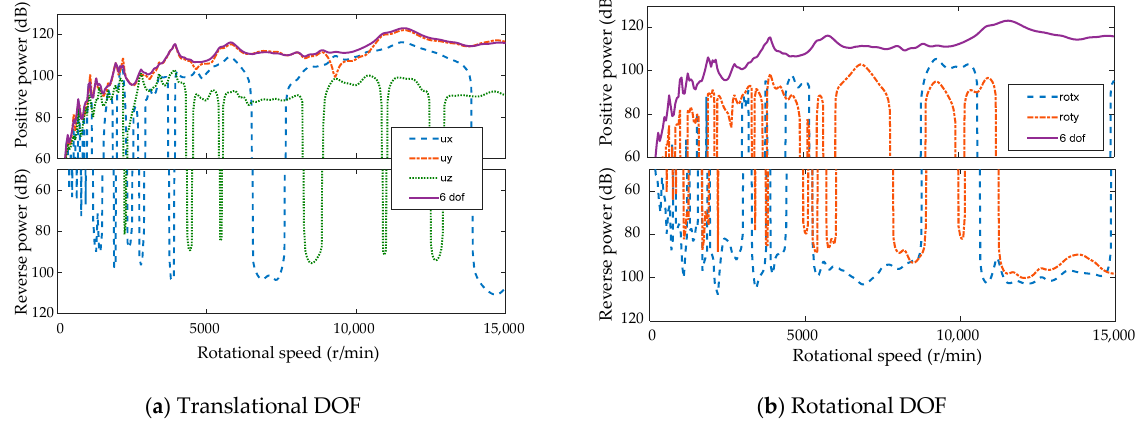
Figure 11. Shaft bearing transmi tt ed power—location path. Shaft bearing vibration power corresponding to the direction transfer path is shown in Figure 12. The vibration power is mainly transmi tt ed to the uy DOF of bearings. The vibration of ux DOF is the largest near 9050 r/min ~ 9650 r/min. Ux and uy also contribute to a certain extent at low speed. The overall vibration power is always positive, and the vibration power in the direction of uy is also constantly positive. There is reverse power fl ow in other DOFs at a certain rotating speed. For instance at low speed, the direction of ux and rotx contribute most to the reverse power. On the whole, uz direction and roty direction have less in fl uence on the vibration.